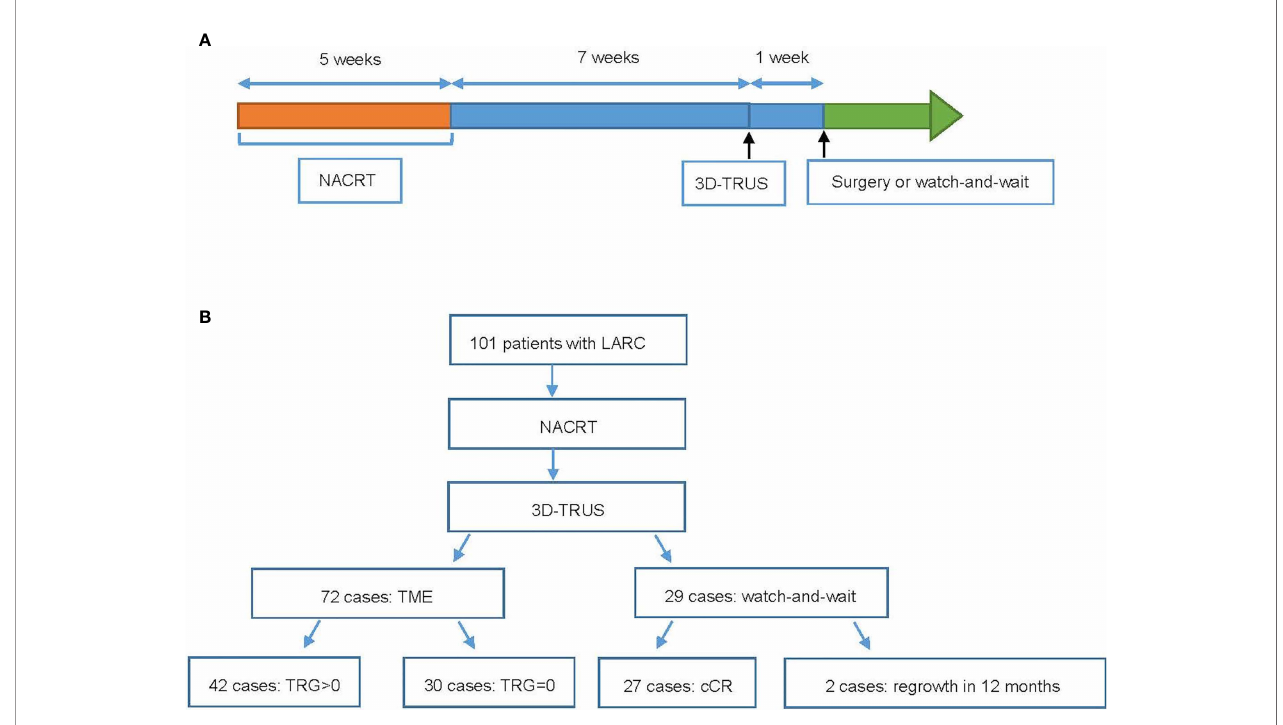
FIGURE 1 | Study design and recruitment. (A) Study design. (B) Recruitment